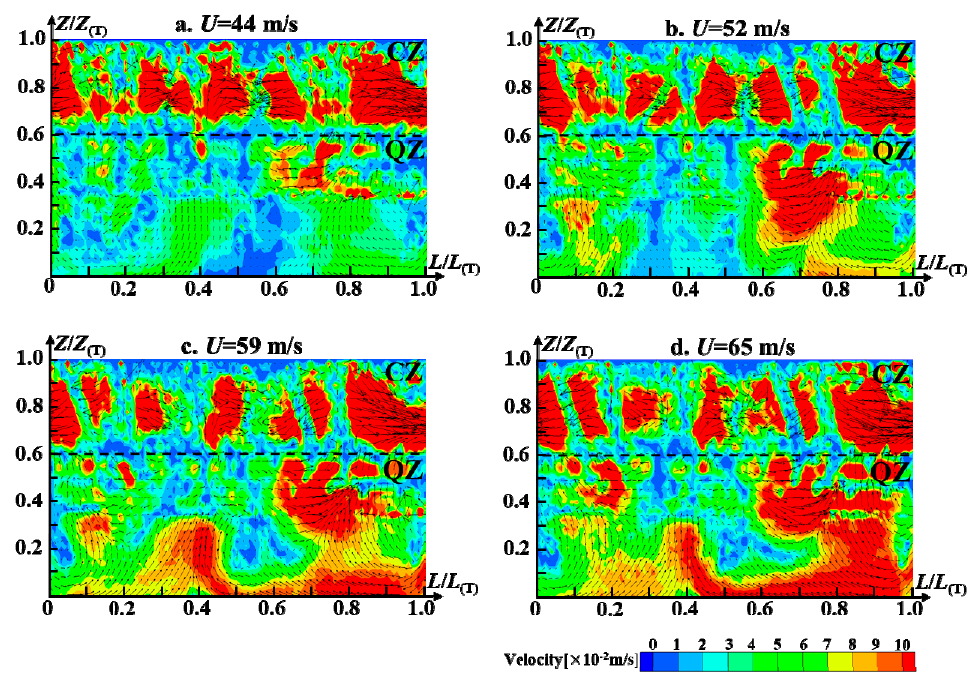
Figure 9. Flow patterns under different gas velocities. (CZ: Chaotic zone; QZ: Quiet zone).